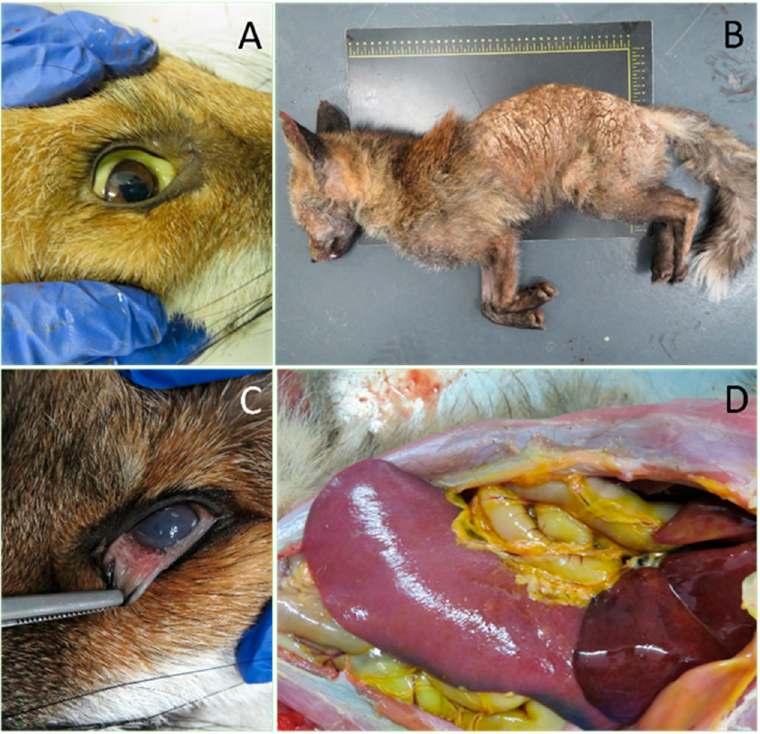
Figure 2. Zoonotic diseases in red foxes: ( A ) Icteric mucosa due to Leptospirosis; ( B ) Cutaneous lesions due to sarcoptic scabies Sarcoptes scabiae; ( C ) Presence of eyeworms Thelazia spp.; ( D ) Enlarged spleen due to Leishmaniosis.